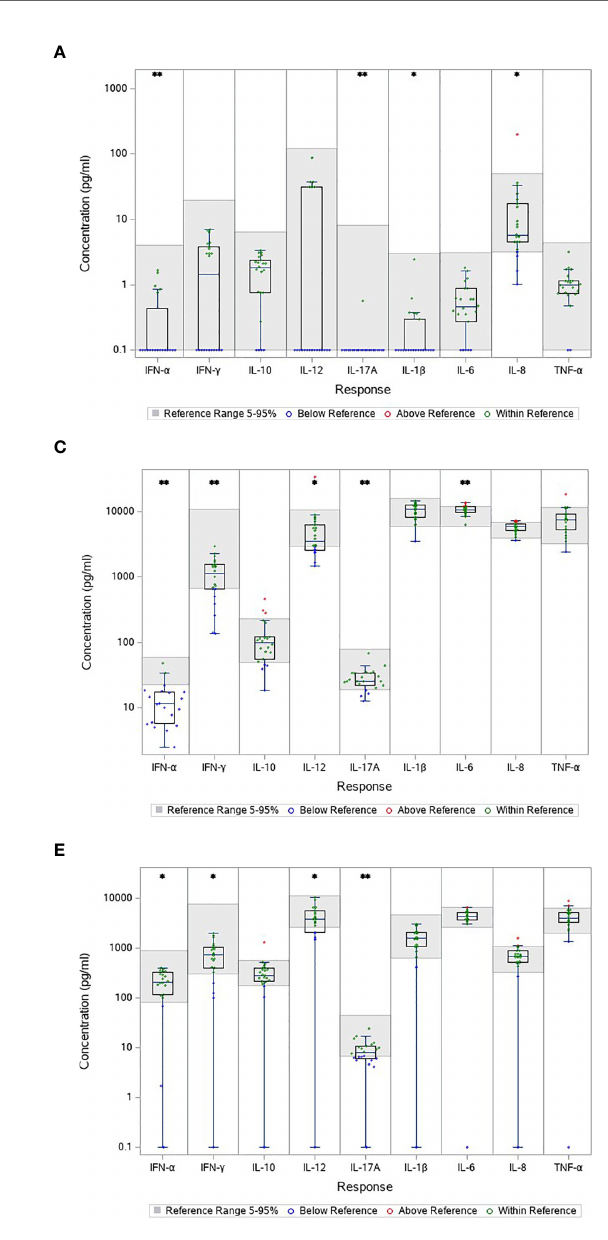
FIGURE 2 | Cytokine concentration in unstimulated (A) and stimulated blood samples (B – E) from patients with LNB. The gray area represents the reference interval and every concentration is shown individually as color coded dots. Comparison between cytokine concentration in blood from patients with LNB and the reference. * p < 0.05. ** p < 0.001. (A) NULL (B) HCKA (C) LPS (D) POLY I:C (E)